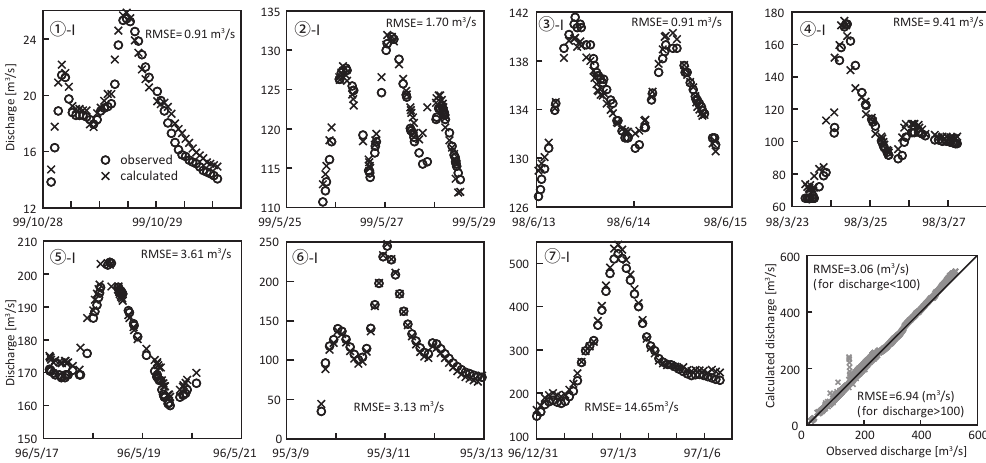
Figure 6. Comparison of calculated discharge and observed discharge.